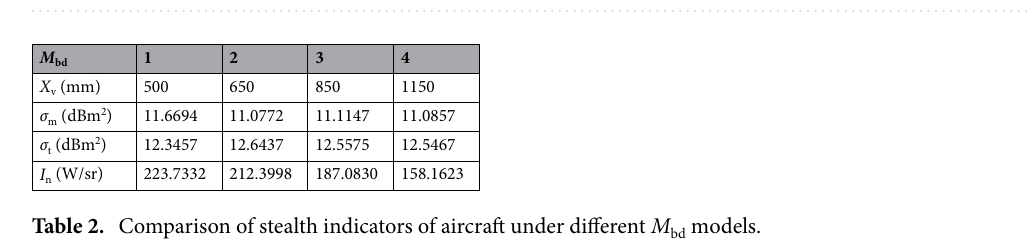
Figure 14 manifests that the difference between RCS and IR curves of aircraft under different W